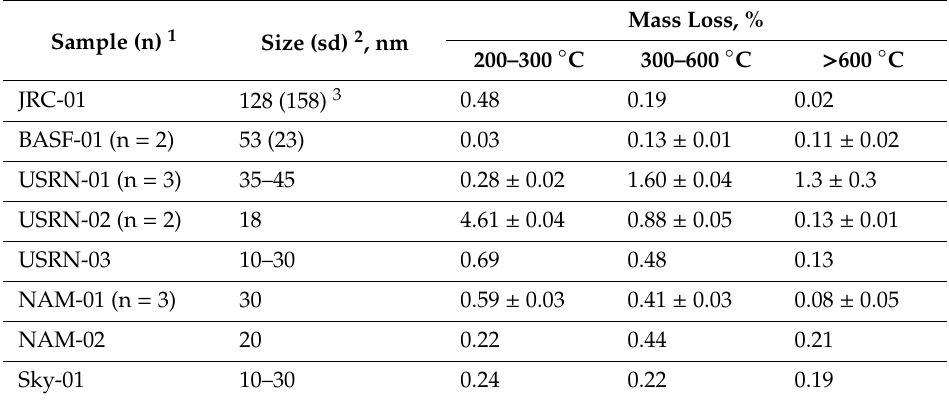
Figure 1. Representative thermograms of bare ZnO samples: ( A ) JRC-01, ( B ) NAM-01, ( C ) USRN-02, and ( D ) USRN-03. Note that the y-axis for ( C ) has a di ff erent range for clarity of presentation of and ( D ) USRN-03. Note that the y-axis for ( C ) has a different range for clarity of presentation of the the results. results. Table 1. Thermogravimetric analysis of unmodified ZnO NPs from various